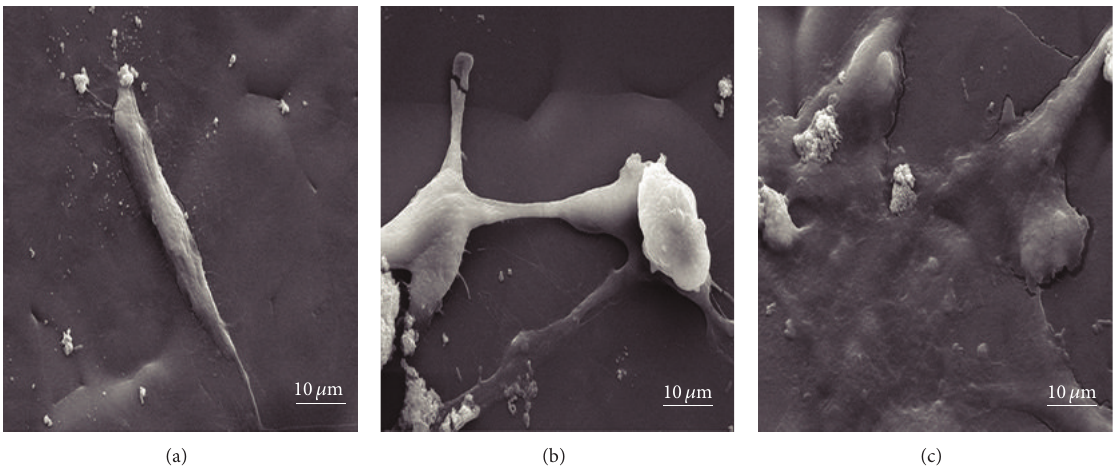
Figure 8: MG63 cells cultured on PVDF scaffolds for different days: (a) 1 day; (b) 3 days; (c) 5 days.